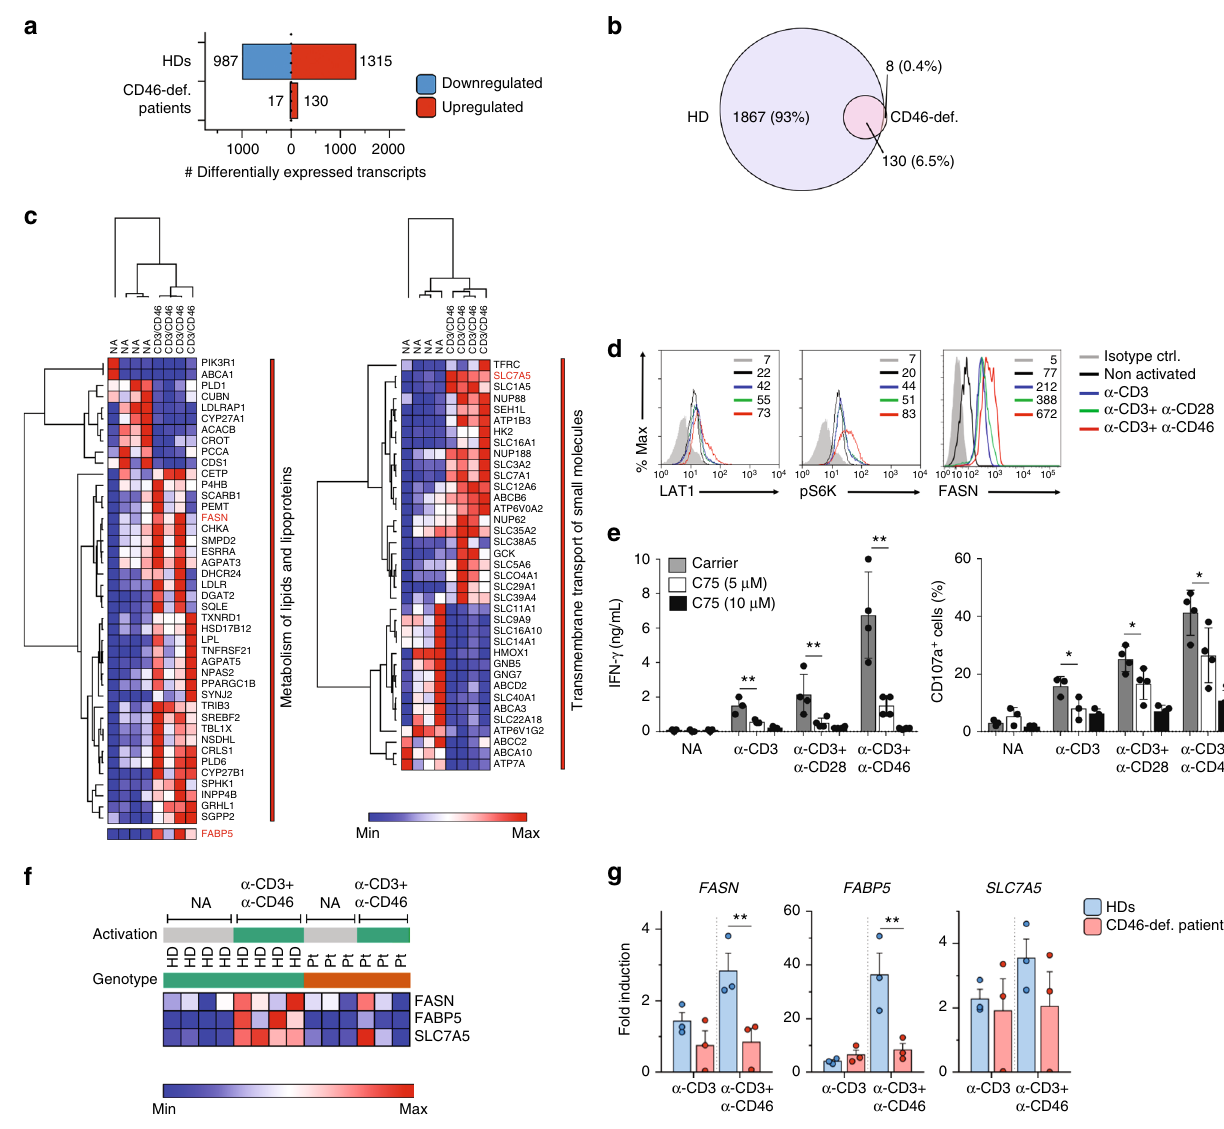
Fig. 6 CD46 co-stimulation augments nutrient in fl ux and fatty-acid synthesis. a , b Differentially expressed genes in CD8 + T cells of four healthy donors (HD) and three CD46-de fi cient (CD46-def.) patients (CD46-2 to -4) upon CD3 + CD46 activation at 6 h ( a ) and Venn diagram indicating overlap between differentially expressed transcripts ( b ). c Heatmaps comparing non-activated (NA) and CD3 + CD46-activated (6 h) HD CTLs with focus on genes involved in lipid/lipoprotein metabolism (left), transmembrane solute transport pathways (right), and FABP5 (left below). d Effect of CD46 co- stimulation on LAT1 and FASN expression and on mTOR activation. CD8 + T cells (gated as in Supplementary Fig. 7b; gray histograms, isotype controls; black histograms, non-activated cells; blue, green, or red histograms, CD3, CD3 + CD28, or CD3 + CD46 activation, respectively) from HDs were left NA or stimulated as depicted and LAT1 and FASN expression and mTOR activity (70S6K phosphorylation) measured 48 h post activation ( n = 4). e Effect of FASN inhibition on IFN- γ production and degranulation of CTLs. CD8 + T cells were activated as in ( d ) in the presence or absence of the FASN inhibitor C75 and IFN- γ secretion and CD107a expression measured at 48 h post activation ( n = 3 – 4; gray bars, carrier addition; white bars, addition of 5 μ M C75; black bars, addition of 10 μ M C75). f Heatmap indicating FASN, FABP5 and SLC7A5 expression in HD ( n = 4) vs. CD46-de fi cient ( n = 3) CD8 + T cells in resting state and after CD3 + CD46 activation. g RT-PCR for FASN , FABP5 , and SLC7A5 in CD3 or CD3 + CD46-activated CD8 + T cells from patients CD46-1, CD46-2, and CD46-4 (light red bars), and three matched HDs (light blue bars) at 6 h post activation ( n = 3). Error bars denote mean ± SEM. * p < 0.05; ** p < 0.01. Statistical analyses were performed using One-way ANOVA with Tukey Multiple Comparison test or the Paired Student ’ s t -test where